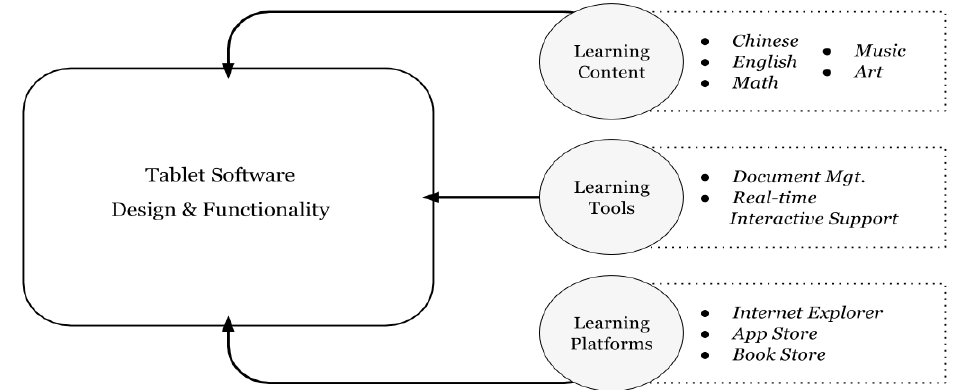
Figure 3. Overview of tablets’ software design and